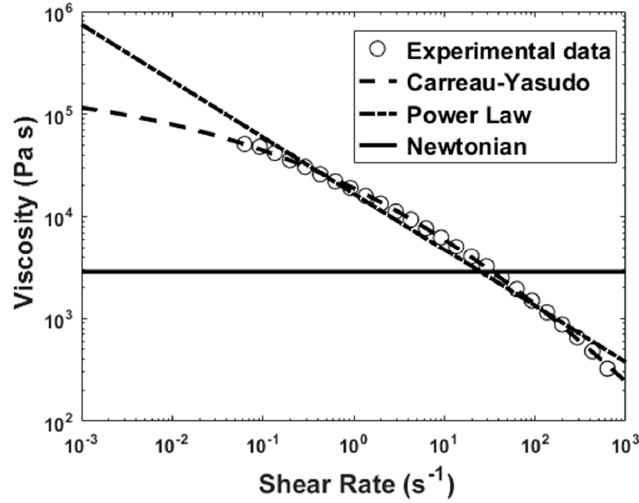
Figure 2. Shear viscosity curve fitting using Generalized Newtonian Fluid models.